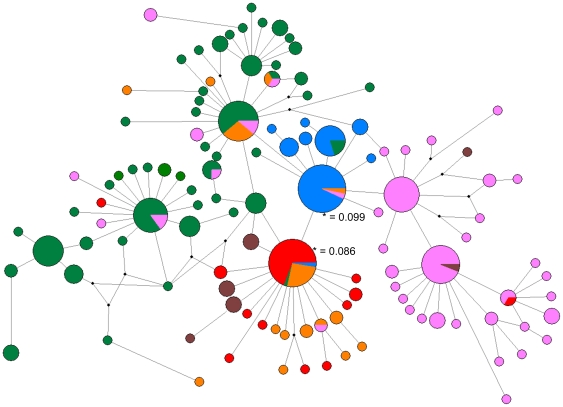
Haplotype network constructed using NETWORK 4.5.0, incorporating 320 P. vivax mitochondrial genome sequences (280 previously published [12]
, [13], and 40 samples from this work).Node sizes are proportional to haplotype frequency. Node colours indicate the geographic origin of the isolates and are coded as follows; red = Africa, blue = South America, green = Asia, pink = Melanesia, orange = the Indian sub-continent, brown = Middle East (Turkey and Iran). Hypothetical intermediates are indicated by small black points. The haplotypes marked with an asterisk are the two with the highest out-group probabilities (see Table S2). Haplotype diversities for geographical regions are given in
Table 2
.